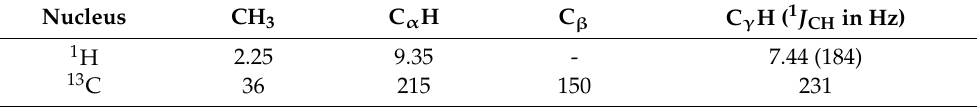
Table 5. Chemical shifts δ * in the MAS NMR spectra of isomer VI in its C 4 H 5+ {Cl 11 − }